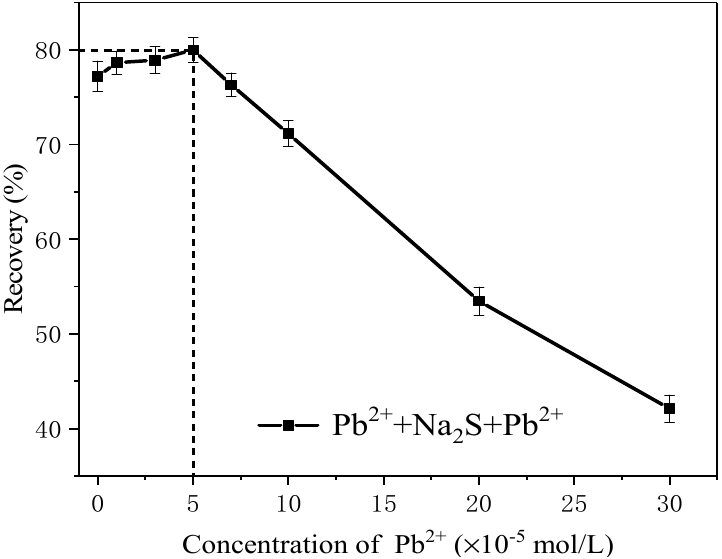
Figure 2. Floatability of hemimorphite with respect to the Pb 2+ concentration for pretreatment (Na 2 S·9H 2 O, 10 × 10 − 4 mol/L; Pb(NO 3 ) 2 , 10 × 10 − 4 mol/L; pH = 10.5).